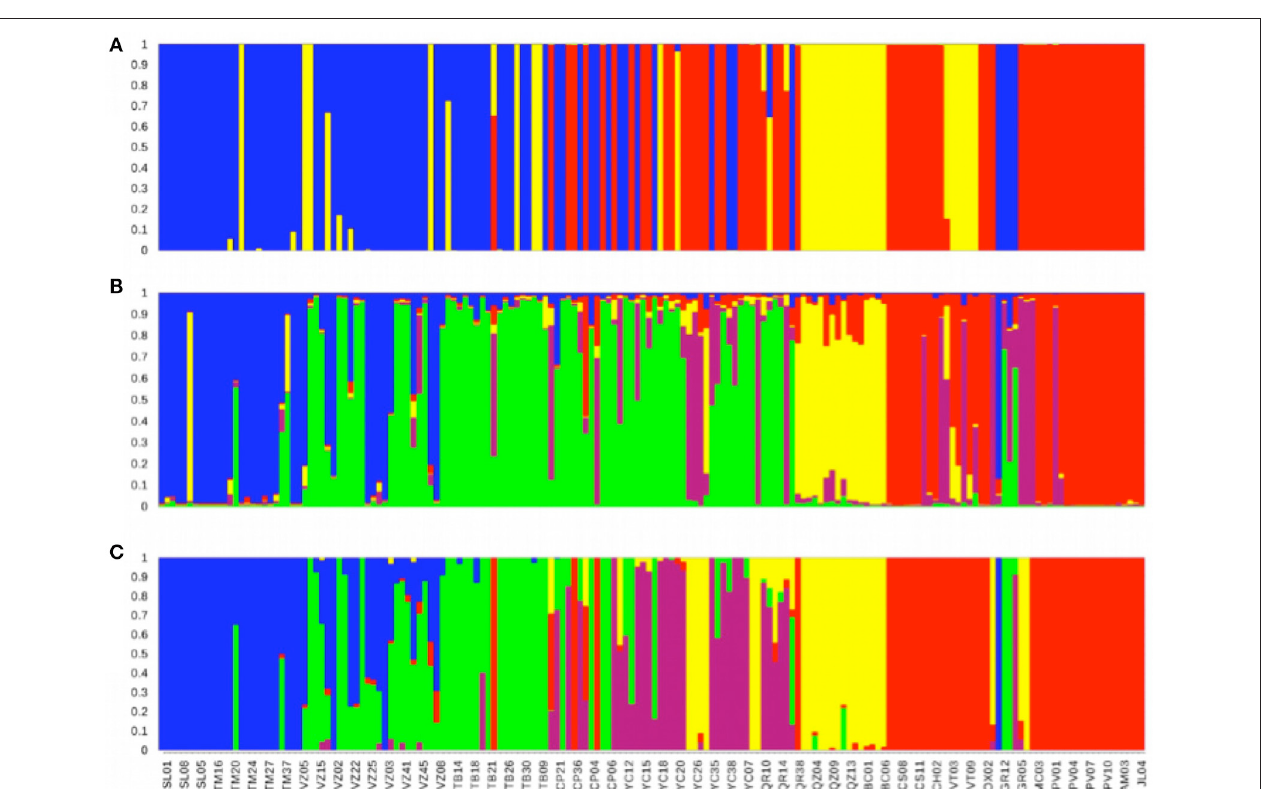
FIGURE 3 | Genetic structure, admixture, and hybridization in Crocodylus acutus and C. moreletii . Admixture proportions results for the 190 individuals subset, representing the maximum number of clusters for each genetic marker, based on (A) mtDNA ( K = 3; STRUCTURE), (B) microsatellites ( K = 5; STRUCTURE ), and (C) SNPs ( K = 5; F ASTSTRUCTURE) . Samples are ordered following the geographic cline from northeast to southeast along the Gulf of Mexico and Caribbean, following then along the Pacific from southwest to northwest (see Figure 1 ).